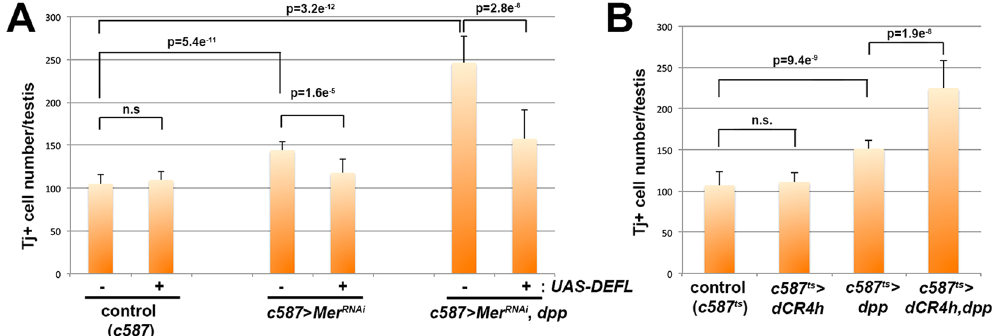
Figure 5. E-cadherin functionally interacts with Mer and Dpp in regulation of CySC/CC proliferation. ( A ) Tj + CC number in control, Mer RNAi , and Mer RNAi ; nos > dpp testes in the presence or absence of E-cadherin overexpression. N = 15 testes for each data point. ( B ) Tj + CC number in control, c587 > dCR4h, c587 > dpp , and c587 > dCR4h, dpp testes. c587-gal4 was combined with tub-gal80 ts , and expression was induced upon eclosion by shifting young males from 18 °C to 29 °C for 7 days. N ≥ 15 testes for each data point. p values were obtained using the Student’s t test